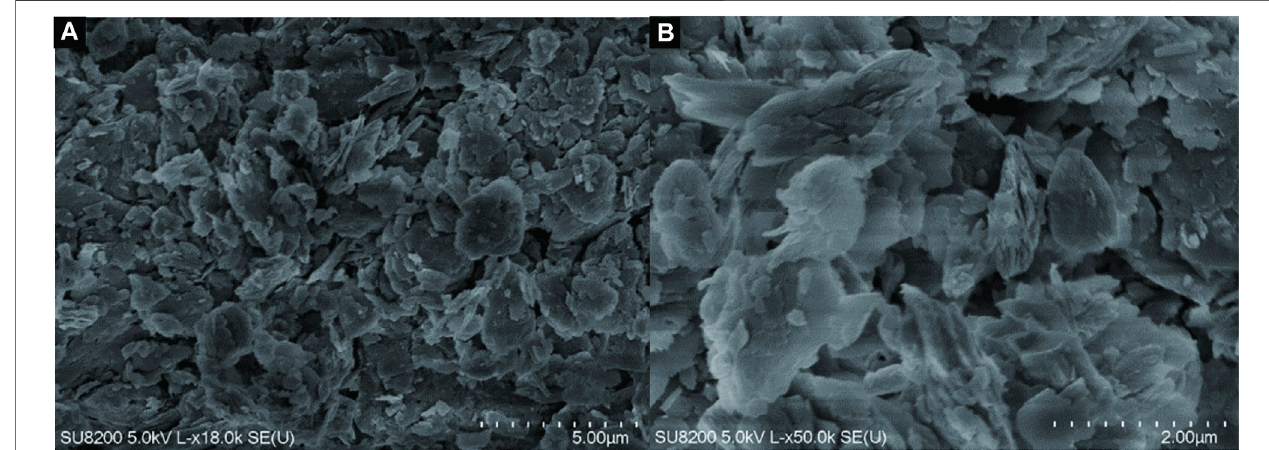
FIGURE 5 | Electron microscopic characteristics (A) reservoir sample Ⅰ ; (B) reservoir sample Ⅱ